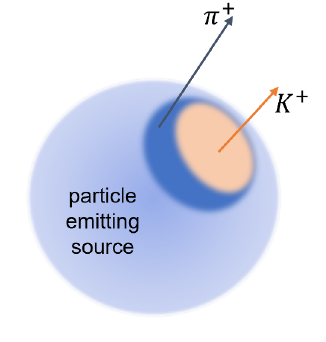
Figure 1. A schematic view of a particle emitting